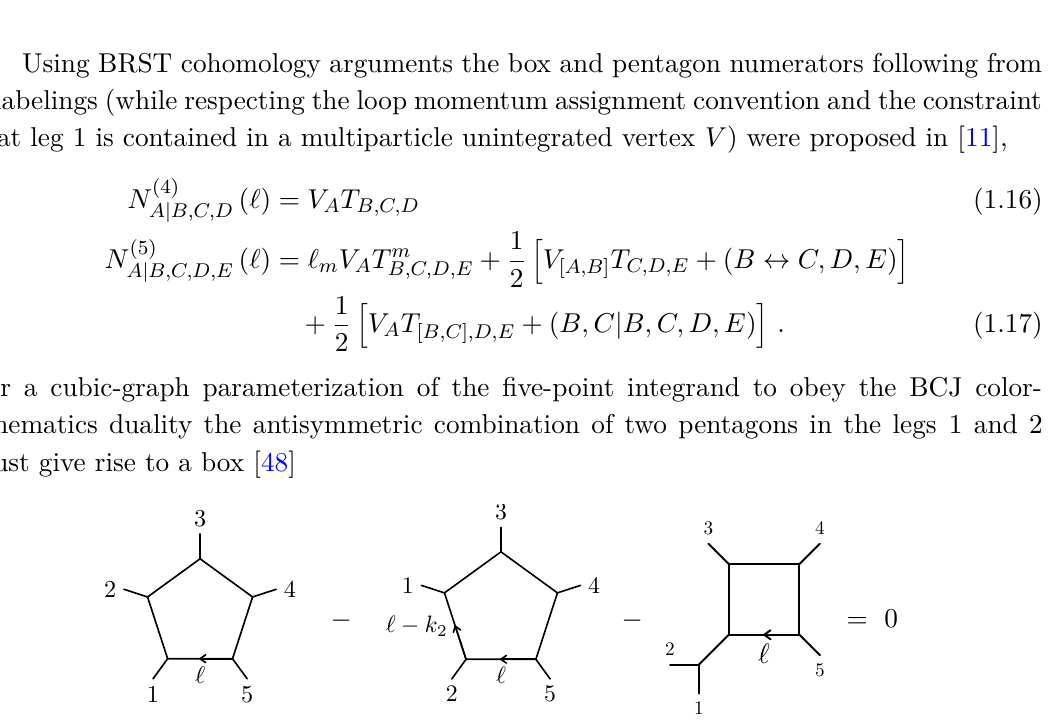
Figure 2 . The cubic graph associated to the pentagon N (5) convention for the loop momentum ‘ is to run from the last argument of the numerator to the